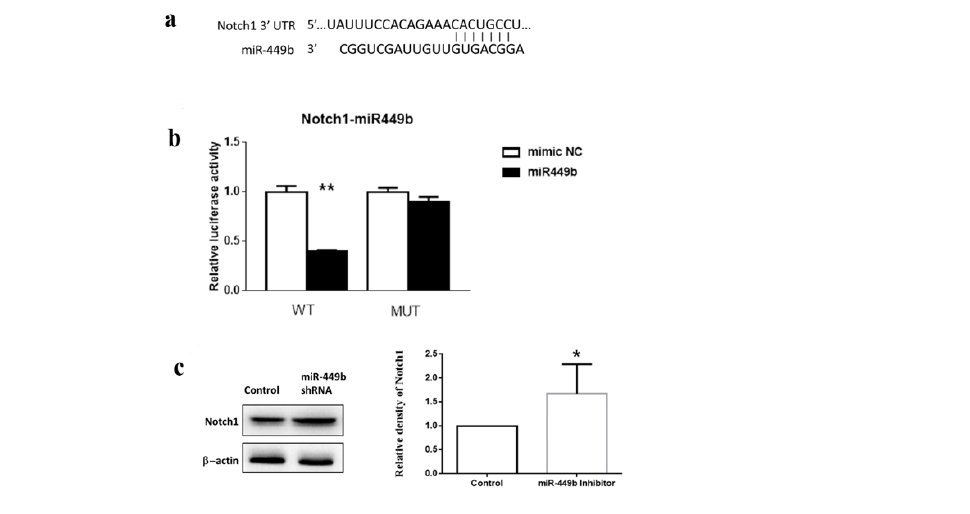
Figure 9. miR-449b/Notch1 signaling pathway modulated NE-4C proliferation. ( a ) Representation of immunofluorescence staining. ( b ) Bar graph shows BrdU-positive cells. N = 6 per group. * p < 0.05, ** p < 0.01.